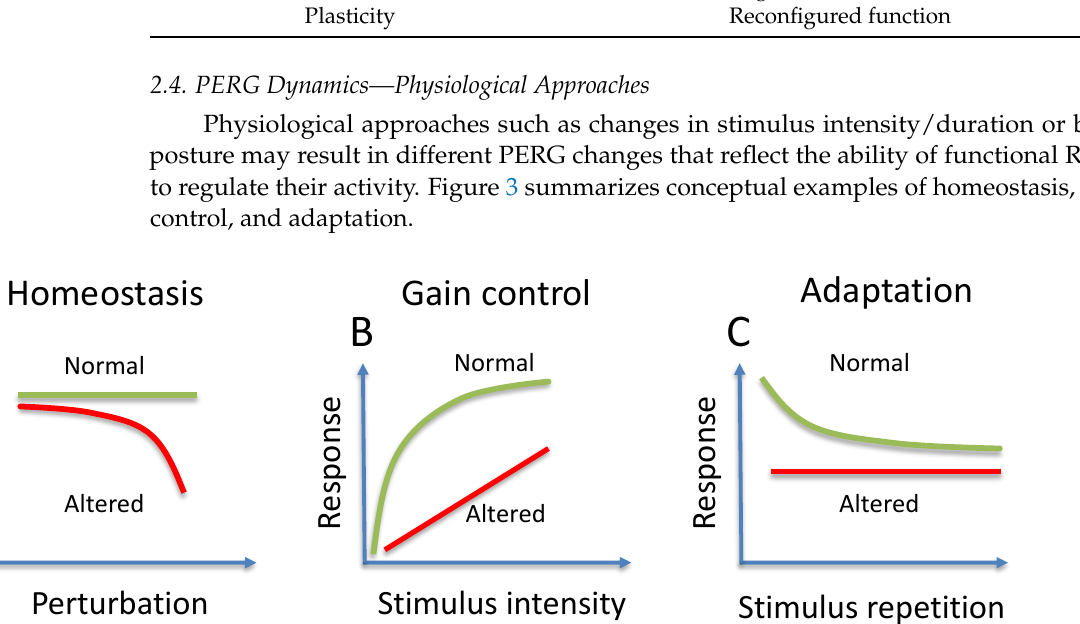
Figure 3. Conceptual examples of normal (green lines) and altered (red lines) homeostasis ( A ), gain control ( B ), and adaptation ( C ).